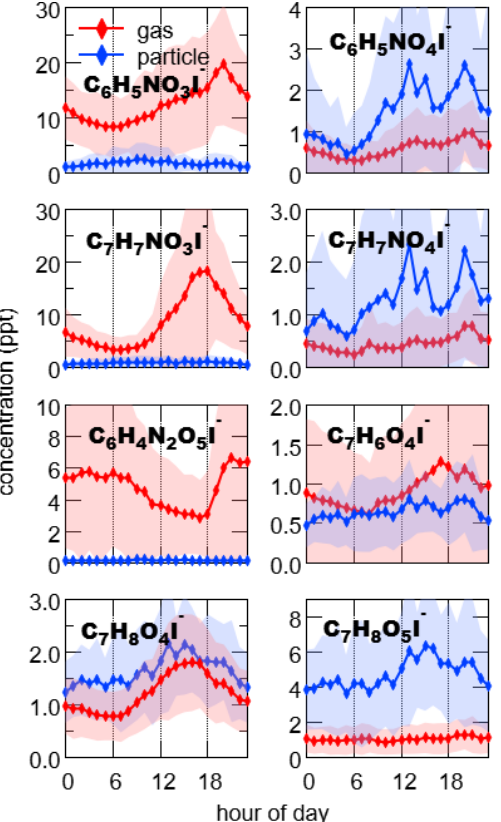
Figure 4. Diurnal variations of oxidized aromatics including nitro-phenols (C 6 H 5 NO 3 I − ) , nitro-benzenediols (C 6 H 5 NO 4 I − ), methyl nitro-phenols (C 7 H 7 NO 3 I − ) , methyl nitro-benzenediols (C 7 H 7 NO 4 I − ) , dinitro-phenols (C 6 H 4 N 2 O 5 I − ) , dihydroxy methyl benzoquinone (C 7 H 6 O 4 I − ), tetrahydroxy toluene (C 7 H 8 O 4 I − ), pentahydroxy toluene and fragments of C 9 aromatics (C 7 H 8 O 5 I − ). The shaded areas indicate 1 standard deviation.